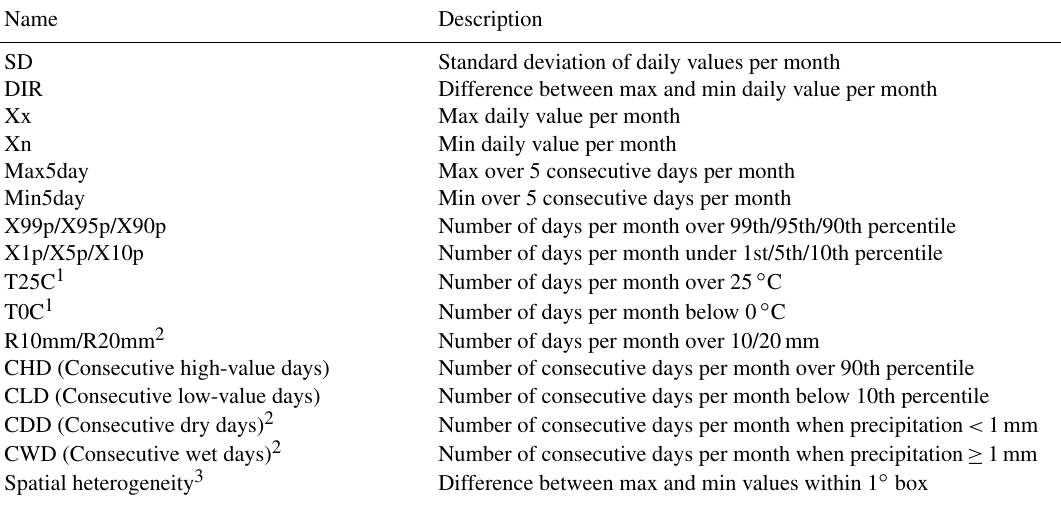
Table 2. Extreme indices considered as predictive variables. These indices are derived from the raw (daily) data and the (daily) anomalies of the data sets in Table 1. We also calculate the lagged and cumulative variables from these extreme indices.